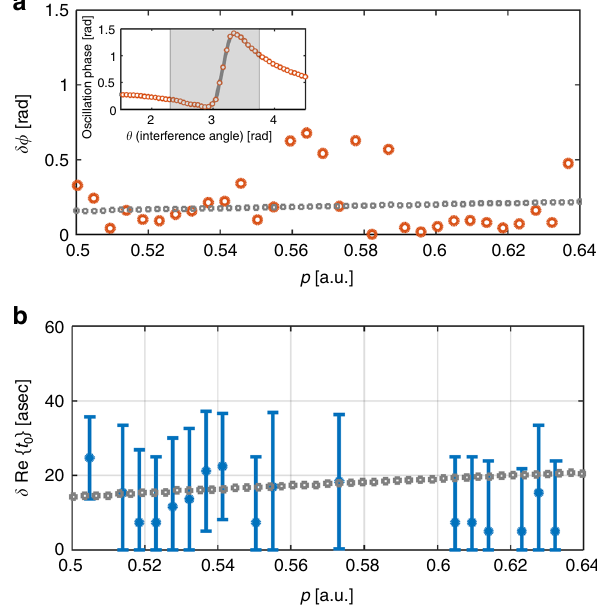
Fig. 4 Reconstruction of the photoelectron hologram dynamics. a Reconstructed values for δϕ (red circles). The horizontal axis represents the absolute value of the momentum for which the reconstruction was performed. The CCSFA values for δϕ (gray squares) along the dip of the spider pattern are also shown. The experimental results and the CCSFA results are consistent and show a very minor dependence of δϕ on p . Inset: The experimentally measured two-color oscillation phase extracted along the equal energy curve (de fi ned by p j j ¼ 0 : 5 a.u.), shown in Fig. 2b. The gray line shows the fi t of our model to the experiment (red circles). The fi t is performed within a narrow region around the dip (gray region). b Reconstructed values of the difference in ionization times, δ Re{ t 0 } (blue dots). The horizontal axis is the absolute value of the momentum. The CCSFA values for δ Re{ t 0 } (gray squares) along the dip of the spider pattern are also shown. Note that for the narrow momentum range 0.56a.u. < p < 0.59 a.u., some reconstructed δϕ values are beyond the range predicted by the CCSFA (due to experimental error limitations), and so the corresponding δ Re{ t 0 } could not be reconstructed. An estimation of the error bars is explained in Supplementary Note 7